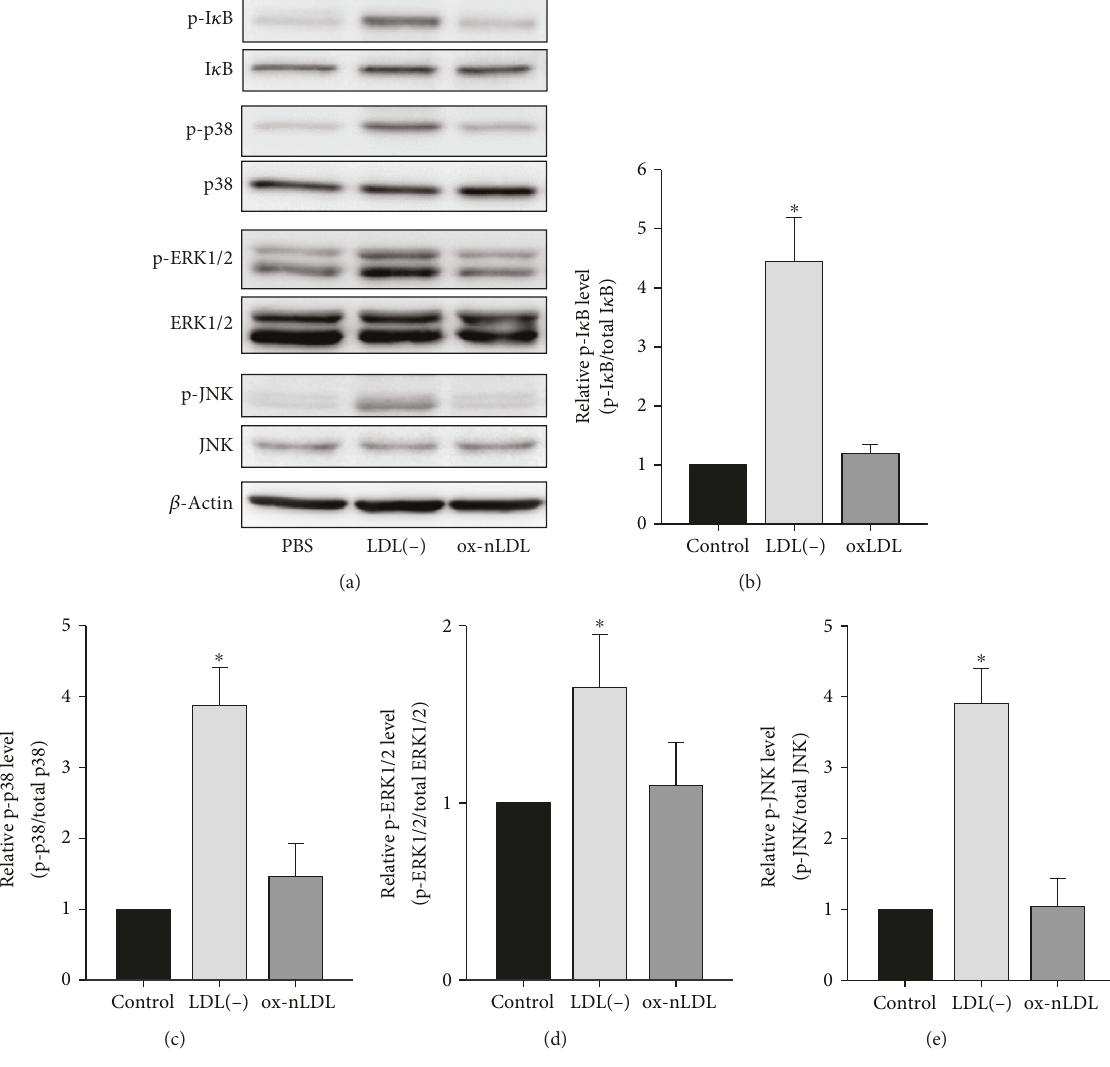
Figure 6: E ff ects of LDL(-) and Cu-ox-nLDL on the activation of I κ B, p38, ERK1/2, and JNK in THP-1 macrophages. (a) Cells were treated with 20 μ g/ml of LDL(-) or Cu-ox-nLDL for 2 h, and then levels of phosphorylated I κ B (p-I κ B), total I κ B, p-p38, total p38, p-ERK1/2, total ERK1/2, p-JNK, and total JNK were determined by Western blotting. β -Actin was used as a loading control. (b – e) Protein levels were quanti fi ed using ImageJ software, and relative levels of p-I κ B/total I κ B (b), p-p38/total p38 (c), p-ERK1/2/total ERK1/2 (d), and p-JNK/total JNK (e) are expressed relative to PBS-treated cells ( relativelevel = 1 ). Values are the mean ± SD of three independent experiments. ∗ p < 0 05 , compared to corresponding PBS-treated and Cu-ox-nLDL-treated